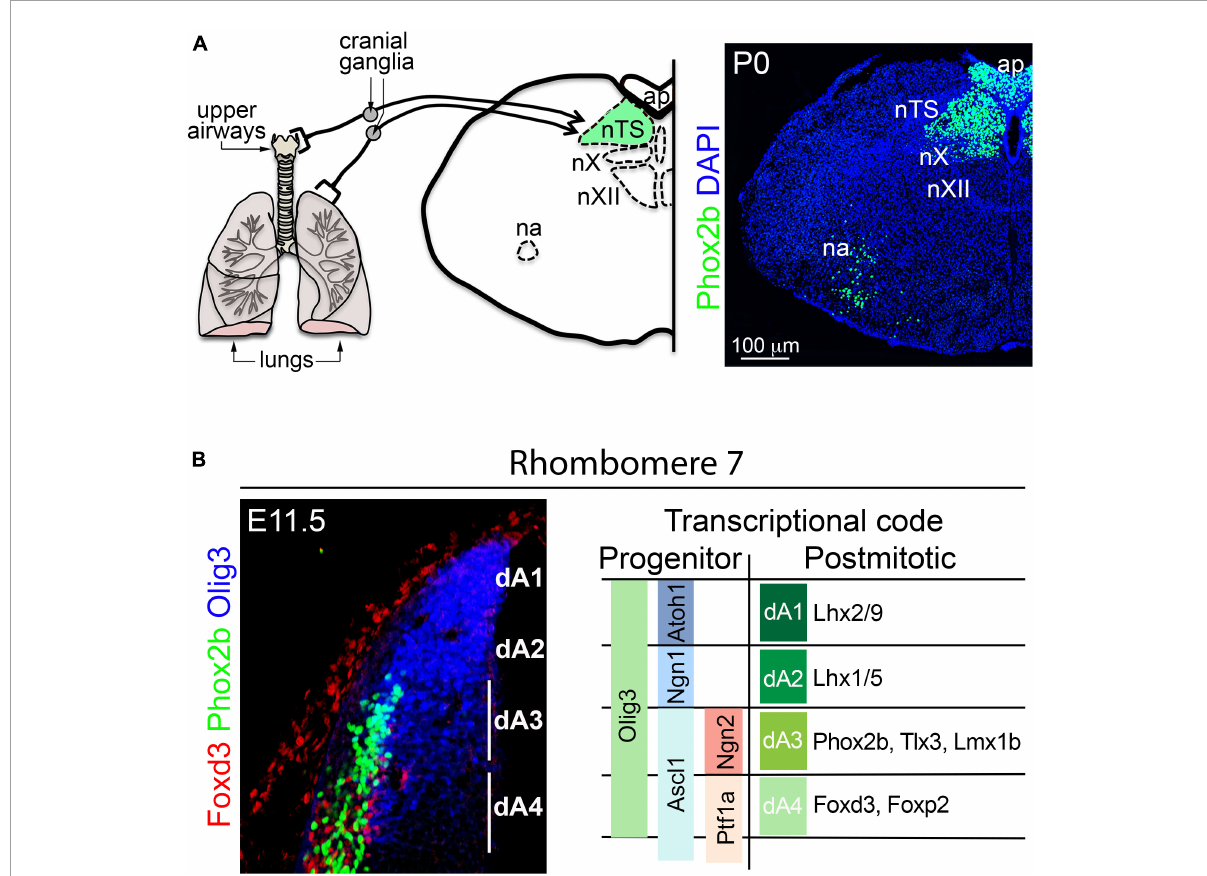
FIGURE5 Development of the nucleus tractus solitarius. (A) Left, schema illustrating the relay of sensory information from the upper and lower airways to the nucleus tractus solitarius (nTS) by cranial (vagal) ganglion neurons. The nucleus ambiguus (na), area postrema (ap), nucleus vagus (nX), and the nucleus hypoglossus (nXII) are displayed as landmarks. Right, transverse section of the brainstem stained with antibodies against Phox2b and counterstained with DAPI. Phox2b expression can be observed in nTS, ap, nX and na neurons. (B) Left, transverse section of the dorsal rhombomere 7 stained with antibodies against Olig3, Phox2b and Foxd3 at E11.5 in mice. The expression of Olig3 encompasses the progenitor domains dA1-dA4. Phox2b and Foxd3 are differentially express in neurons emerging from dA3 and dA4, respectively. Right, schema illustrating the differential expression of transcription factors in dA progenitor cells and neurons of the dorsal rhombomere 7. This figure is adapted from our previous publication Isik and Hernandez-Miranda (2022) in Handbook of Clinical Neurology, Chapter 5, entitled Early development of the breathing network, published by Elsevier Books. The license number 5392080585902 between Hernandez-Miranda, Charite Universitätsmedizin Berlin and Elsevier allows us to reuse it in a journal/magazine. The primary data used in this figure was published in Hernandez-Miranda et al. (2017b) under the terms of the Creative Commons Attribution License, which permits unrestricted use and redistribution, provided that the original author and source are credited